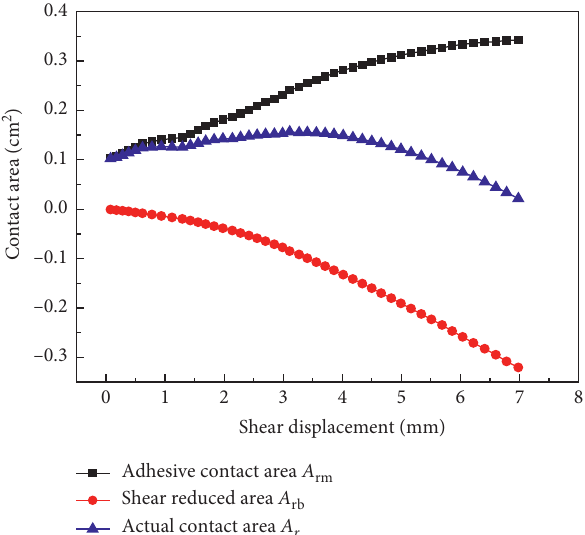
Figure 5: Relationship between shear displacement and the contact